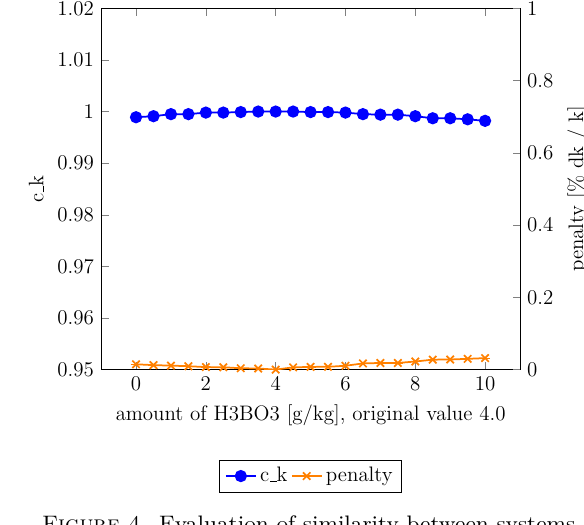
Figure 2. Evaluation of similarity between systems with different enrichments.